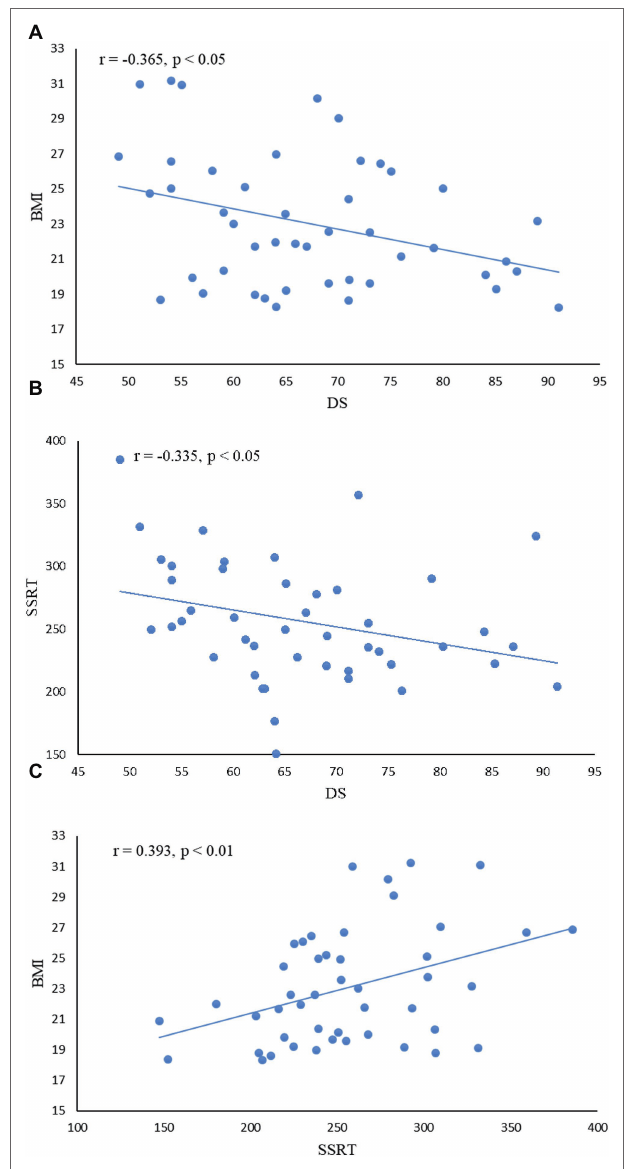
FIGURE 2 | Correlation between disgust sensitivity score (DS), inhibition control index (SSRT), and body mass index (BMI). (A) There was a negative correlation between DS and BMI ( r = − 0.365, p < 0.05), indicating that subjects with low disgust sensitivity had high BMI. (B) DS was negatively correlated with SSRT ( r = − 0.335, p < 0.05), indicating that subjects with low disgust sensitivity had poor control ability. (C) BMI was positively correlated with SSRT ( r = 0.393, p < 0.01), indicating that higher BMI subjects had poorer inhibitory